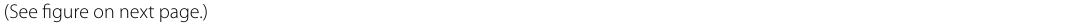
figure on next Fig. 7 The Notch signaling pathway regulated autophagic activity through NICD-induced phosphorylation of ULK1. A Immunofluorescence staining for NICD (red) and ULK1 (green) in HLE-B3 cells cultured under normal-glucose (NC) and high-glucose conditions (HG), bar Co-IP of NICD and ULK1 in normal cultured HLE-B3 cells. IP immunoprecipitation, WB Western blot. D Verification of NICD overexpression plasmids, and detection of the levels of autophagy marker proteins and p-ULK1 after transfected with pEGFP-C3 and pEGFP-C3-NICD plasmids for 36 h in normal cultured HLE-B3 cells (NC) by Western blotting. Quantification of the relative levels of NICD ( E ), p-ULK1/ULK1 ( F ), LC3II/I G and SQSTM1/ p62 ( H ), n 3. ns indicates P > 0.05; * P < 0.05, ** P < 0.01 and **** P < 0.0001 vs. NC group; # P < 0.05, ## P < 0.01 and #### P < 0.0001 vs. HG = group. I Verification of ULK1 and ULK1 (Ser 757) overexpression plasmids, and detection of the levels of proteins in the Notch signaling pathway and p-ULK1 after transfected with pcDNA3.1, pcDNA3.1-ULK1, and pcDNA3.1-ULK1 (S758A) plasmids for 36 h, respectively, in HLE-B3 cells cultured in high-glucose conditions (HG) by Western blot assays. Quantification of the relative levels of ULK1 ( J ), p-ULK1/ULK1 ( K ), Notch1 ( L ), NICD M and Snail ( N ), n 3. ns indicates P > 0.05; * P < 0.05, ** P < 0.01, *** P < 0.001 and **** P < 0.0001 vs. NC group; # P < 0.05, ## P < 0.01 vs. HG = vs. HG pcDNA-ULK1 +